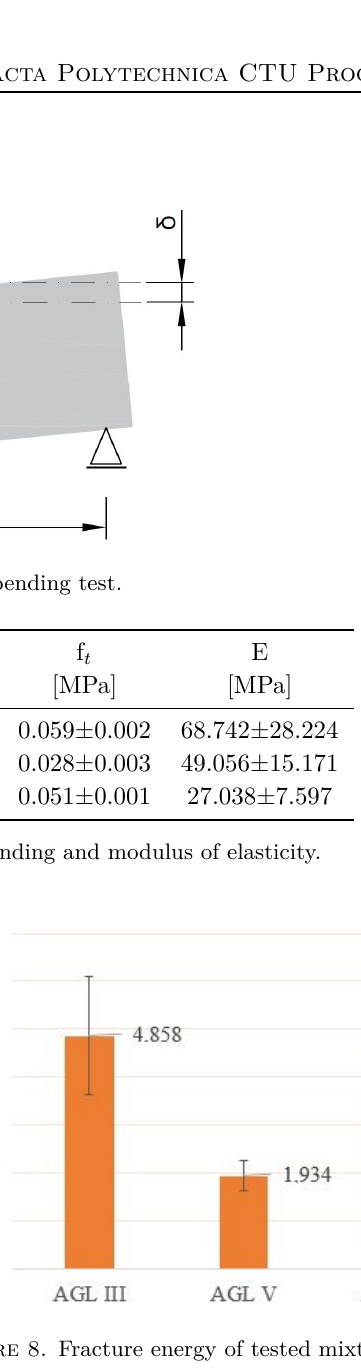
Figure 7. The work to create the crack is the area under F - δ curve.